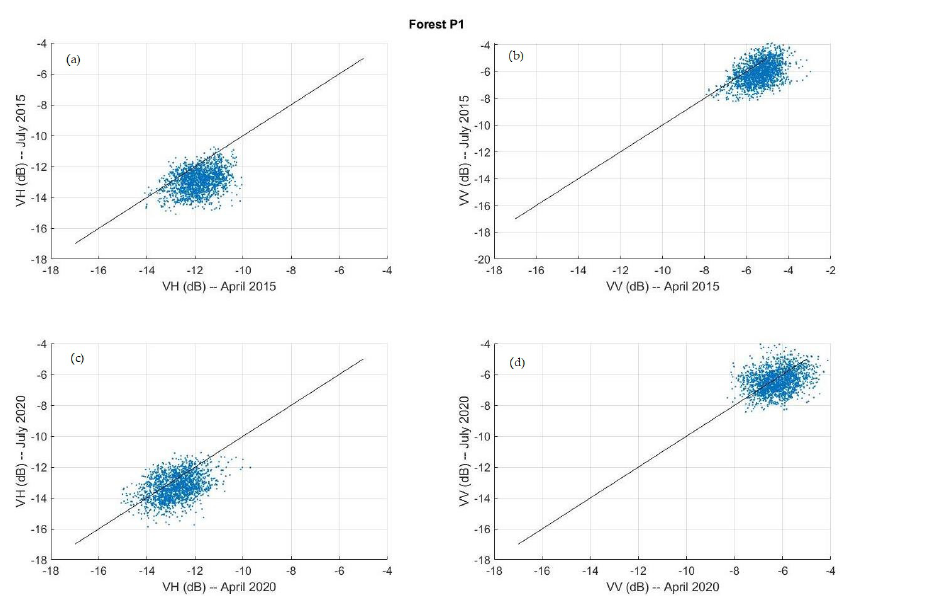
Figure 12. Scatter plots comparing wet and dry seasons in forest polygon F1: ( a ) VH 2015; ( b ) VV 2015; ( c ) VH 2020; and ( d ) VV 2020.